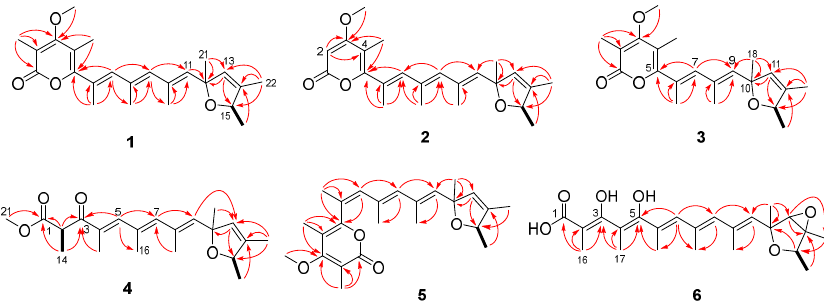
Table 1. 1 H-NMR Data of Compounds 1 – 6 (500 MHz, DMSO- d 6 , δ in ppm, J in Hz).